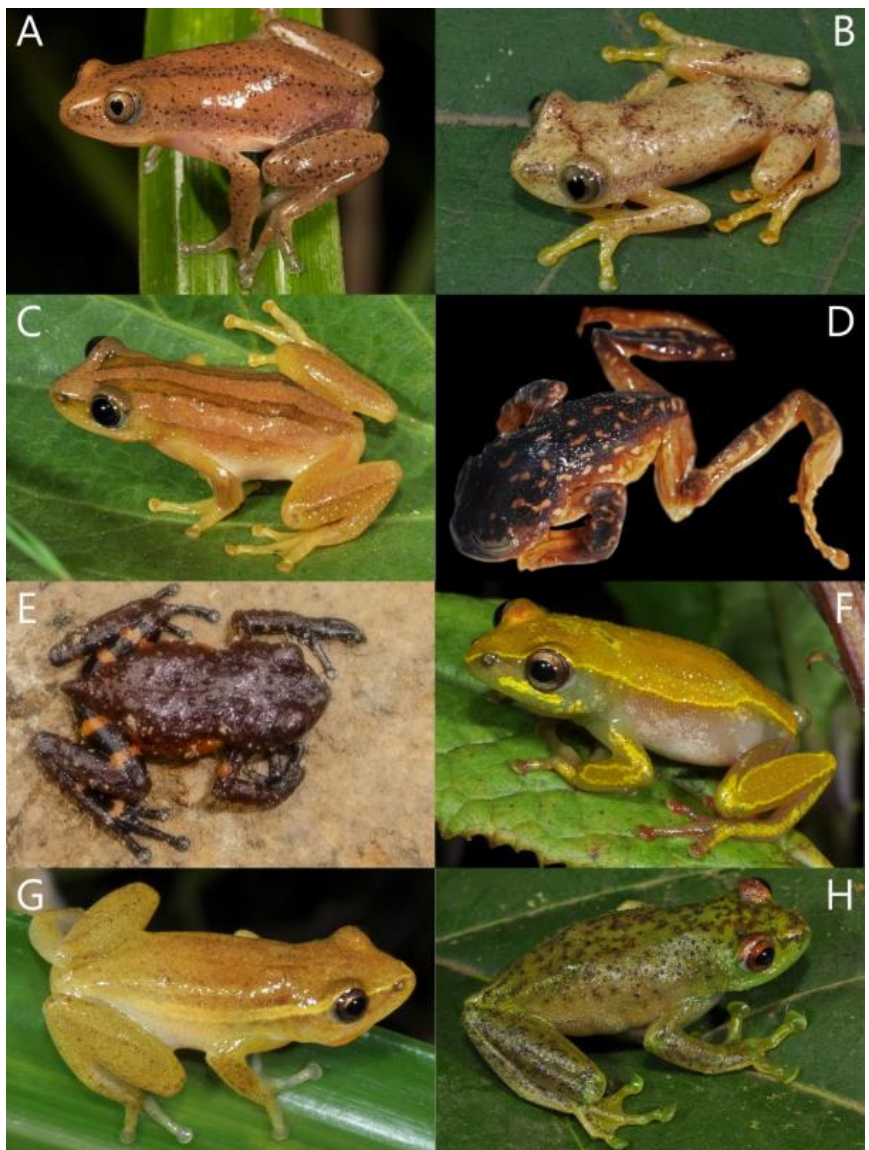
Figure 6. Rwandan species of Hyperoliidae ( A ) Afrixalus orophilus , Rugezi Wetland (photo: J.M.D.), ( B ) Afrixalus phantasma , Nyungwe NP (photo: J.M.D.), ( C ) Afrixalus quadrivittatus , Huye (photo: J.M.D.), ( D ) Callixalus pictus , preserved holotype, RMCA 105145, from Rutsiro, Western Province (photo: J.M.D.), ( E ) Hylambates verrucosus , Kahuzi-Biega NP, DR Congo (photo: Bonny Dumbo), ( F ) Hyperolius castaneus , Nyungwe NP (photo: J.M.D.), ( G ) Hyperolius cinnamomeoventris , Huye (photo: J.M.D.), ( H ) Hyperolius discodactylus , Nyungwe NP (photo: